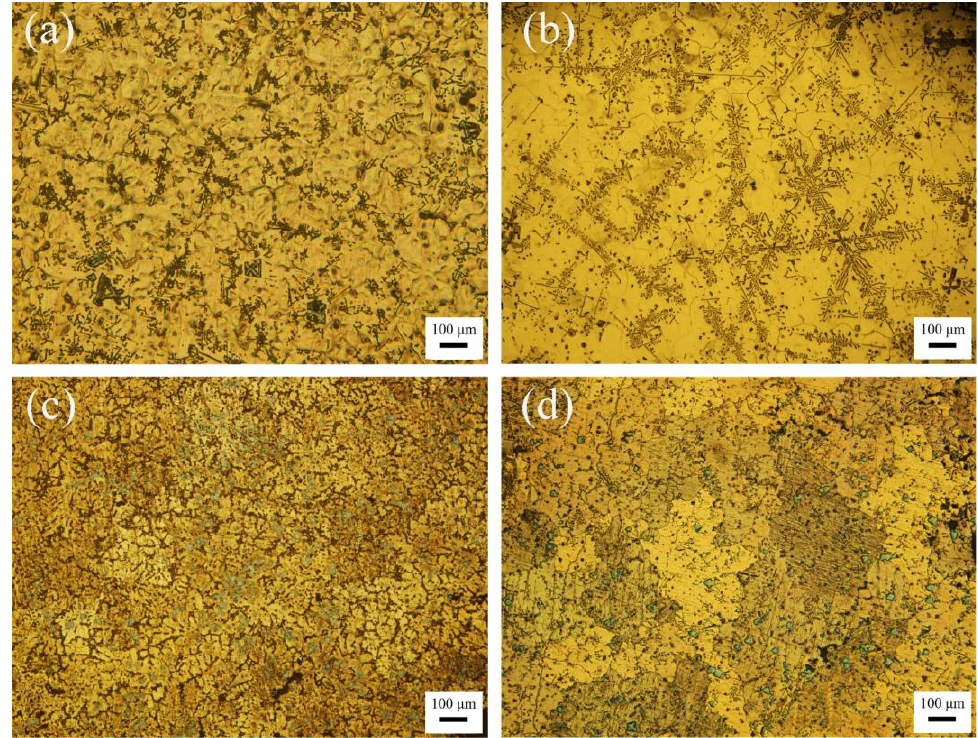
Figure 10. Optical micrographs showing the grain structure of the as-cast alloys ( a ); solution-treated alloys ( b ); as-cast composites ( c ); and solution-treated composites ( d ).